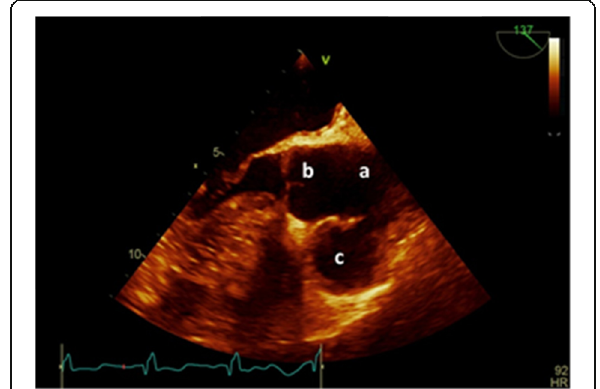
Fig. 2 Trons esophageal echocardiography revealed Large